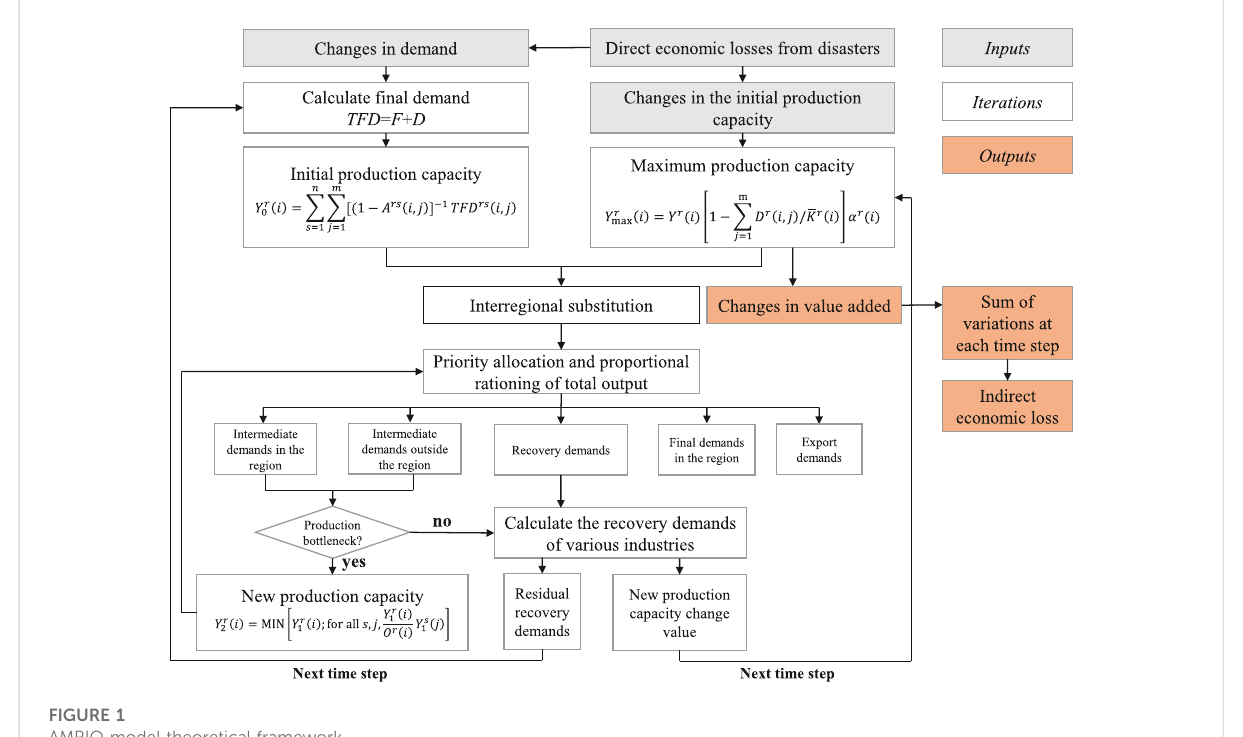
AMRIO model theoretical